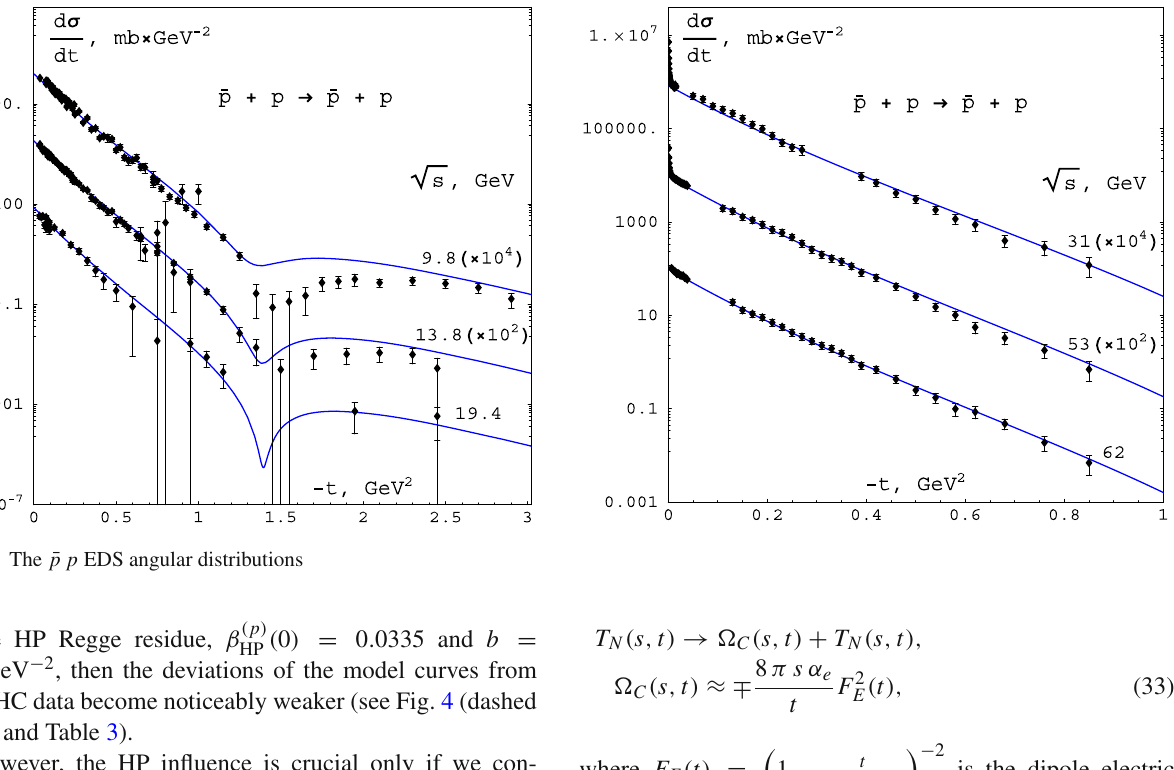
( p ) ( 0 ) = 0 . 0335 and b HP